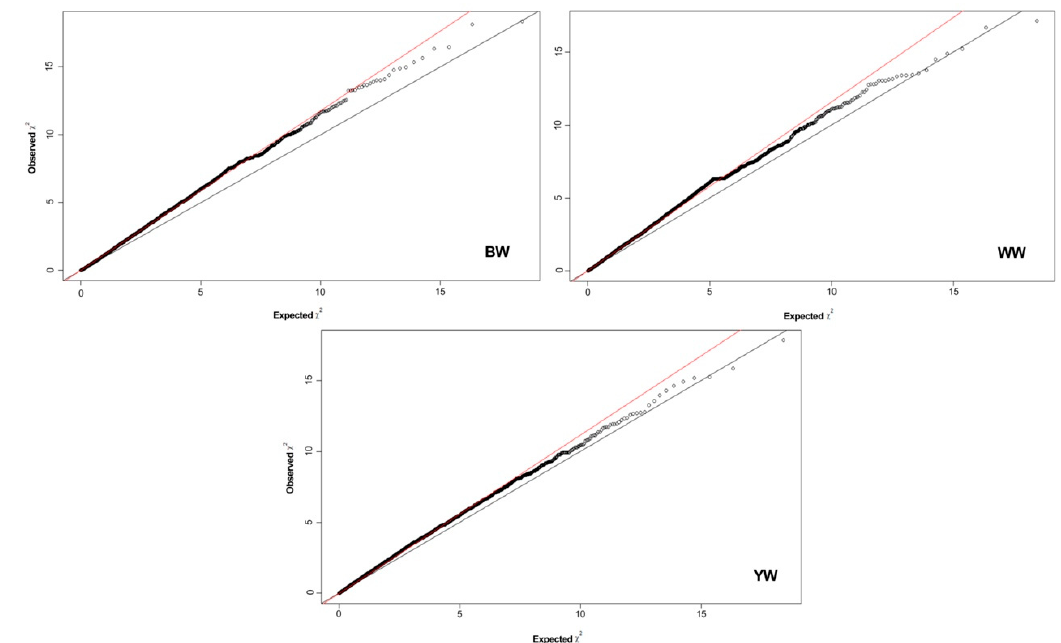
Figure 2. Quantile–quantile (QQ) plots for the genome-wide association study of birth (BW), weaning (WW) and yearling (YW) weight traits in Braunvieh cattle. The straight line in the QQ plots indicates the distribution of SNP markers under the null hypothesis, and the skew at the edge indicates that these markers are more strongly associated with the traits than would be expected by chance. BW = birth weight; WW = weaning weight; YW = yearling weight.